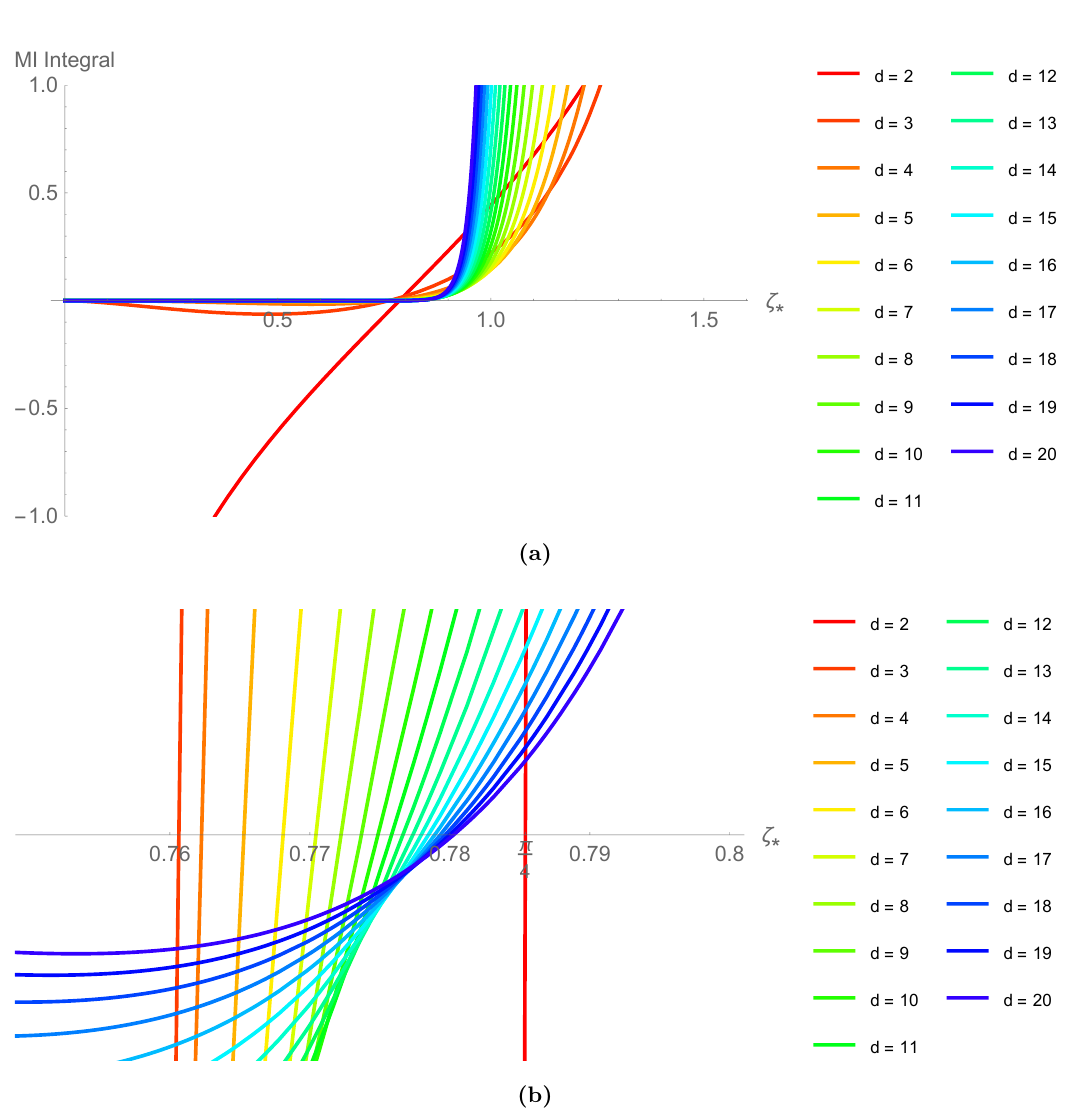
Figure 6 . (a) Plots of the right-hand side of equation (2.41) for all values of d between 2 and 20 : (b) The same plot, zoomed in near (cid:16) (cid:3) = (cid:25)= 4 : We see that the critical value of (cid:16) (cid:3) is exactly (cid:25)= 4 at d = 2, jumps down to (cid:24) 0 : 76 at d = 3, then increases monotonically toward (cid:25)= 4 as d ! 1